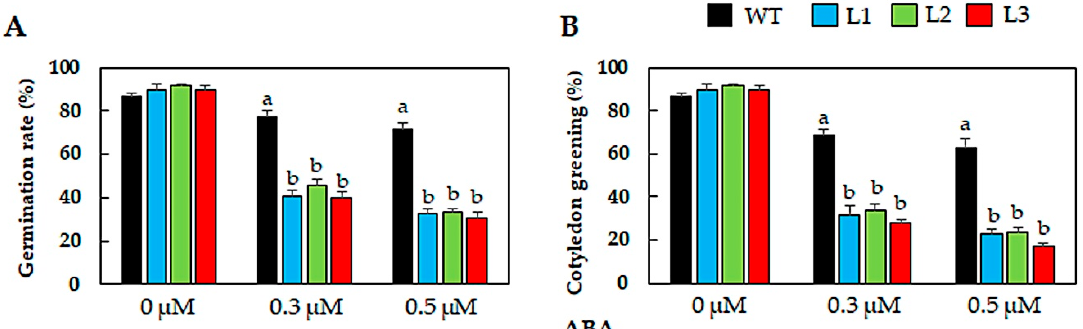
Figure 4. The effects of ABA application on seed germination and cotyledon development of GmNAC019 -transgenic (L1, L2 and L3) versus wild-type (WT) plants. ( A ) Germination rates of seeds that were recorded after three days of growth on MS medium supplied with or without ABA ( n = 3). ( B ) Cotyledon greening rates that were recorded after seven days of growth on MS medium supplied with or without ABA ( n = 3). Error bars represent SEs. Different letters indicate significant differences ( p -value < 0.05) among the genotypes under the same treatment as analyzed by a Duncan’s multiple range test.